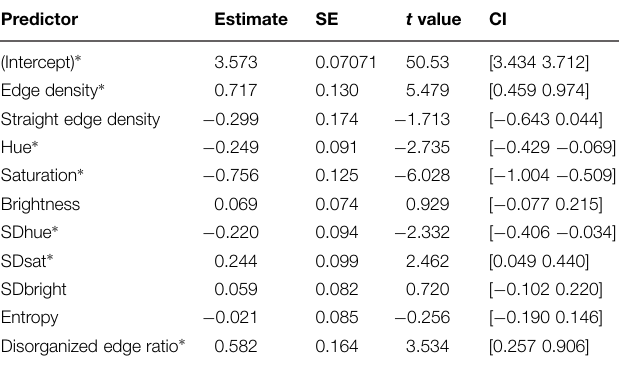
TABLE 2 | Results of regressing perceived naturalness on image features. Predictor